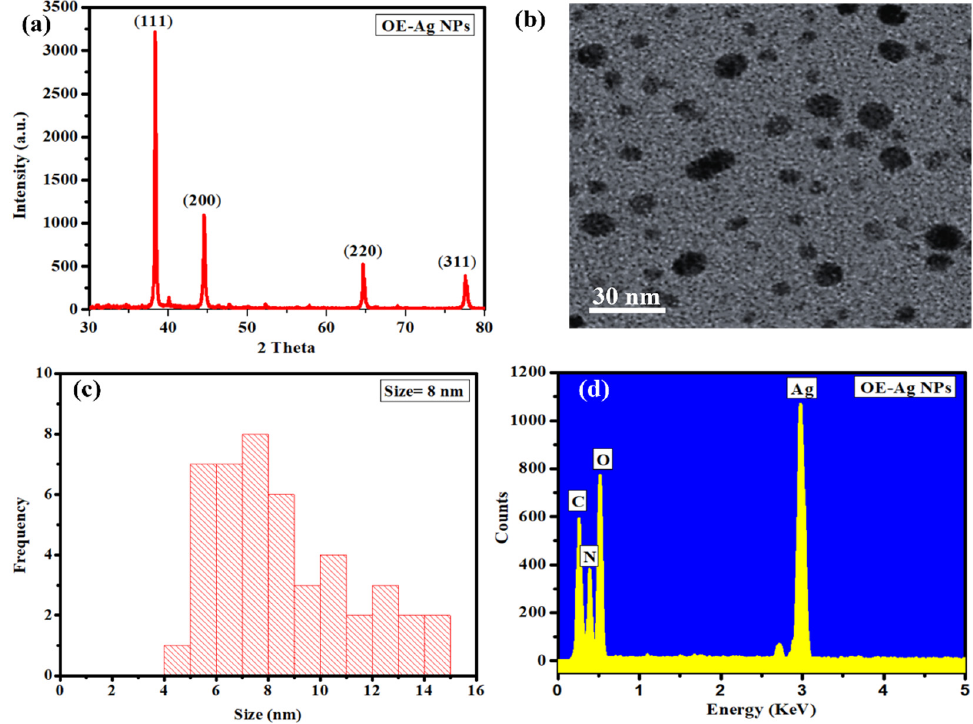
Figure 2. ( a ) XRD, ( b ) TEM, ( c ) Size distribution, and ( d ) EDX analysis of green synthesized OE-Ag NPs.